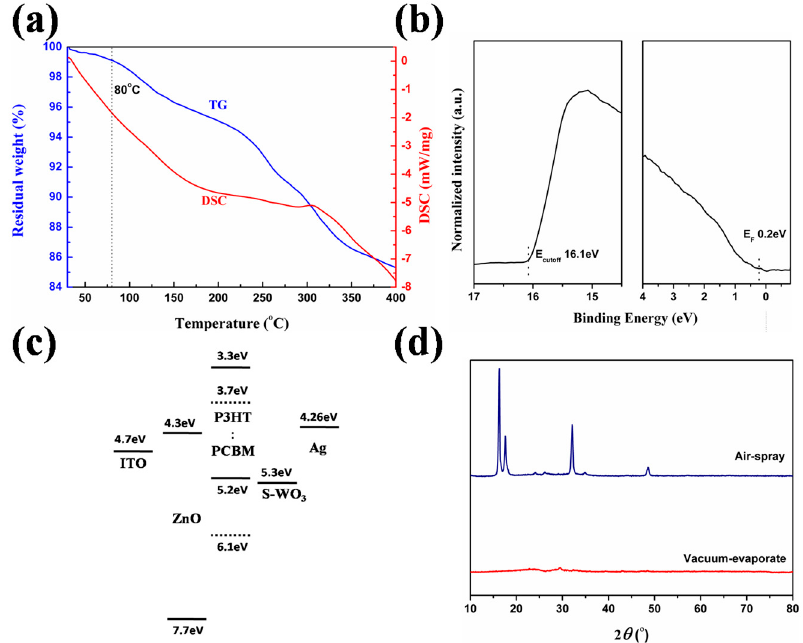
Figure 3. ( a ) Thermo gravimetric (TG) and differential scanning calorimeter (DSC) profiles of the AT precursor; ( b ) ultraviolet photo-electron spectroscopy (UPS) results of S-WO 3 film; ( c ) energy level of